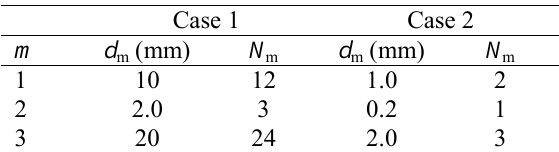
Table 4: Number of elementary cells for d m length in the case 1 and in the case